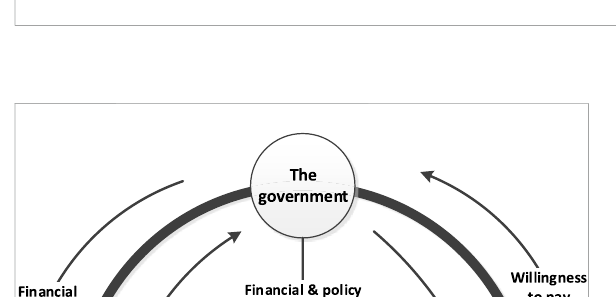
FIGURE 1 Methodological steps.